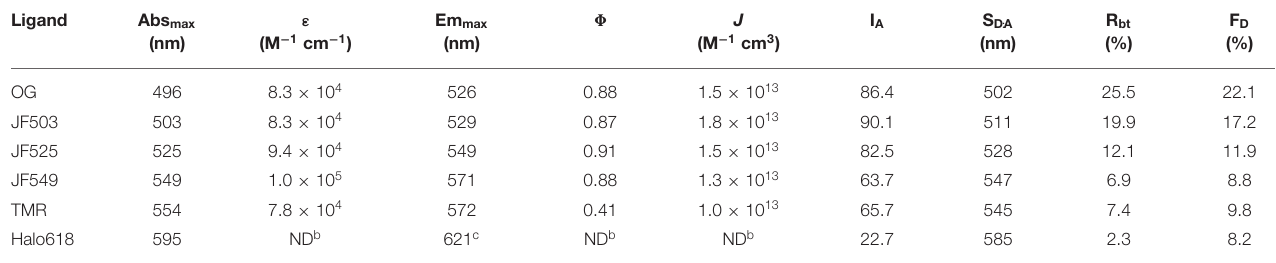
TABLE 1 | Evaluation of HaloTag ligands as BRET acceptors of NanoLuc in vitro a .